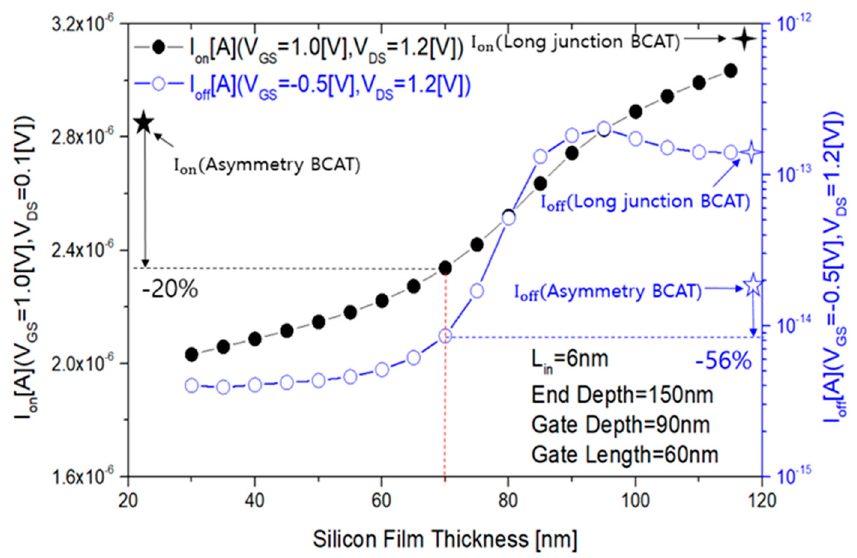
Figure 15. I on and I off change according to the silicon film thickness in Pi-BCAT at a gate depth = 90 nm.